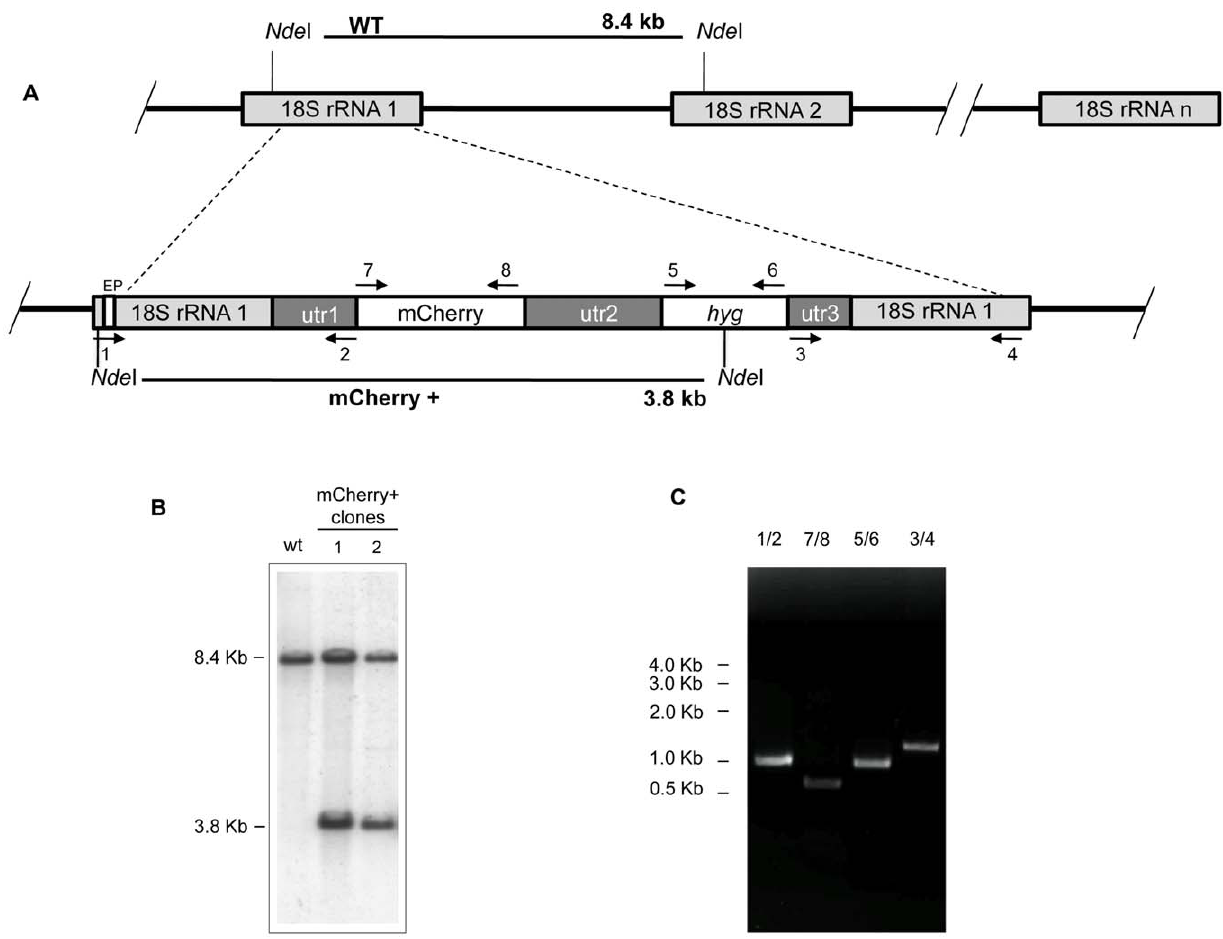
Figure 1. Strategy of integration of mCherry encoding gene into genomic rRNA locus of L.major . A) Scheme of the structure of the 18S rRNA locus on wild type and planned integration of mCherry gene. Key: utr1: 5 9 non-translated region of aprt gene; utr2: 1.4 kb intergenic region from cam operon; and utr3: 5 9 UTR of dhfr - ts gene; hyg ; hygromycin B resistance cassette. The narrow white box on the left side corresponds to the external probe (EP) used for southern blot analyses. B) Southern blot analysis of two L. major clones after selection with hygromycin B. DNA was digested with Nde I and hybridized with the labelled EP. The similar intensities of 8.4 and 3.8 kbp bands could be due to inefficiency transfer of the large band to the membrane. C) PCR confirmation of successful integration of the reporter cassette. Primers 1/2 and 3/4 together confirm the correct integration of the reporter cassette from the 5 9 and 3 9 sides, respectively. Primers 5/6 confirm the presence of the HYG marker, and primers 7/8, 9/10, confirm the presence of mCherry ORF, respectively. Primers: 1(RBF630); 2(RBF637); 3(RBF644); 4(RBF645); 5(RBF646); 6(RBF647); 7(RBF634) and 8(RBF600) (see Table 1 for sequences).